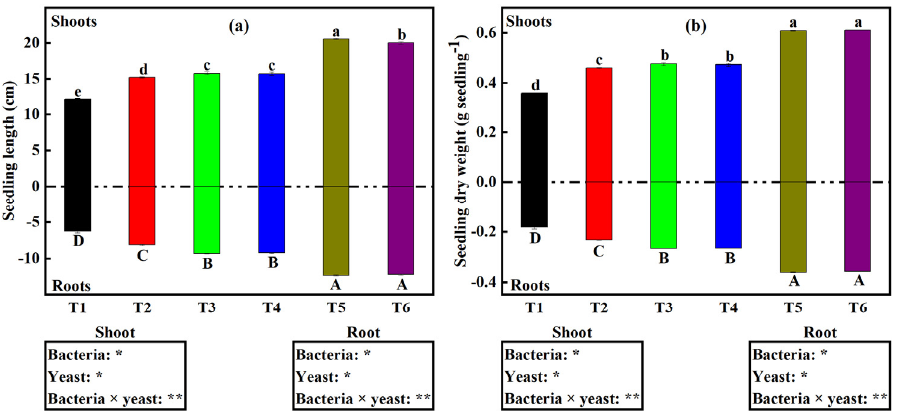
Figure 2. ( a ) Shoot and root length ( b ) shoot and root dry weight, of soybean seedlings under different microbial treatments. Data (means ± SE, n = 5). Bars with lowercase letters and uppercase letters denote shoots and roots, respectively. p -values of two-way ANOVAs followed by different letters denote significant differences between treatments at p < 0.05 according to Tukey’s HSD. p -values of two-way ANOVAs of bacteria, yeast, and their interaction (bacteria × yeast) are indicated: p < 0.05, *; p < 0.01, **; p < 0.001, ***; p < 0.0001, ****; ns, not significant. Treatments: non-inoculated soybeans (T1), soybean inoculated with B. japonicum (T2), S. cerevisiae (T3), S. exiguus (T4), B. japonicum × S. cerevisiae (T5), or B. japonicum × S. exiguus (T6).